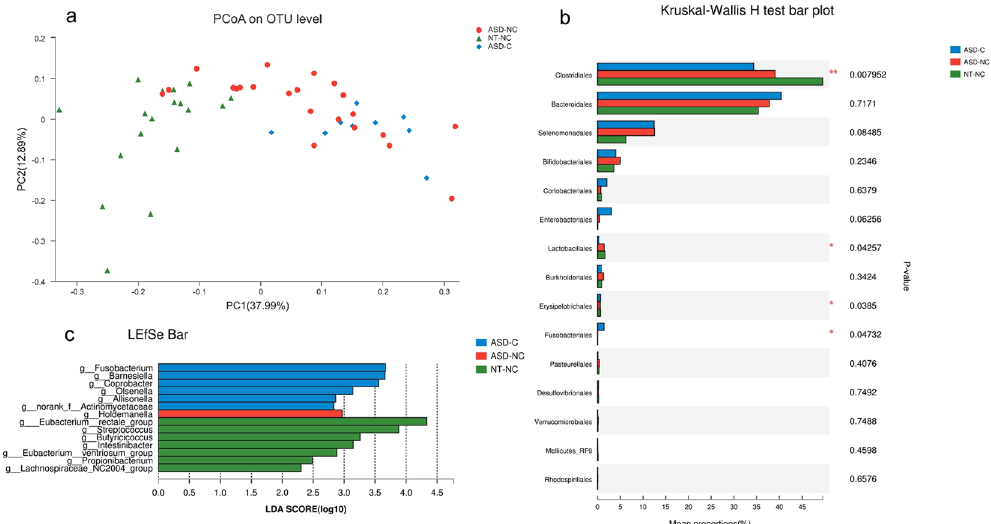
Figure 6. Constipation alters the composition of the gut microbiota in ASD. ( a ) PCoA of beta diversity based on the weighted UniFrac analysis on the OTU level among ASD-C, ASD-NC and NT-NC subjects. ( b ) The mean relative abundances of taxa at the order level in ASD-C, ASD-NC and NT-NC participants. ( c ) LDA scores indicate differentially abundant bacterial taxa associated with ASD-C, ASD-NC and NT-NC subjects (only the taxa having an LDA > 2.0 are shown in the figure). Blue, red and green bars indicate the bacterial taxa enriched in ASD-C, ASD-NC and NT-NC subjects, respectively. * p < 0.05 vs NT group; ** p < 0.01 vs NT